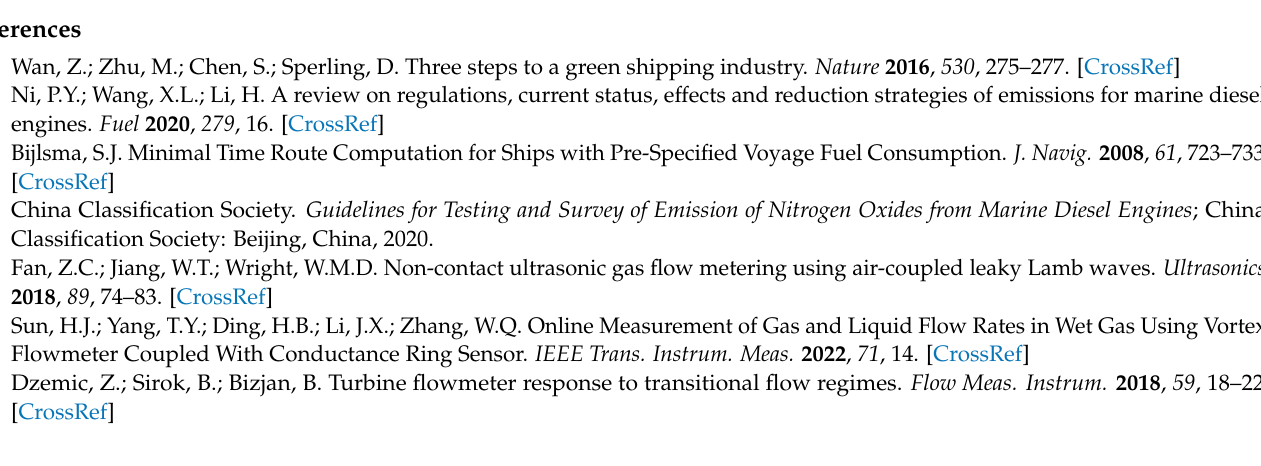
Figure S8: The transferred charge under the PM concentration test; Video S1: Minimum start-up speed test of the B-TENG in Version 4.0; Video S2: Effects of PM on the output performance of the B-TENG; Video S3: Heating process of the B-TENG in the heating box at 180 ◦ C for 10 min; Video S4: Demonstration of the B-TENG as the gas flow